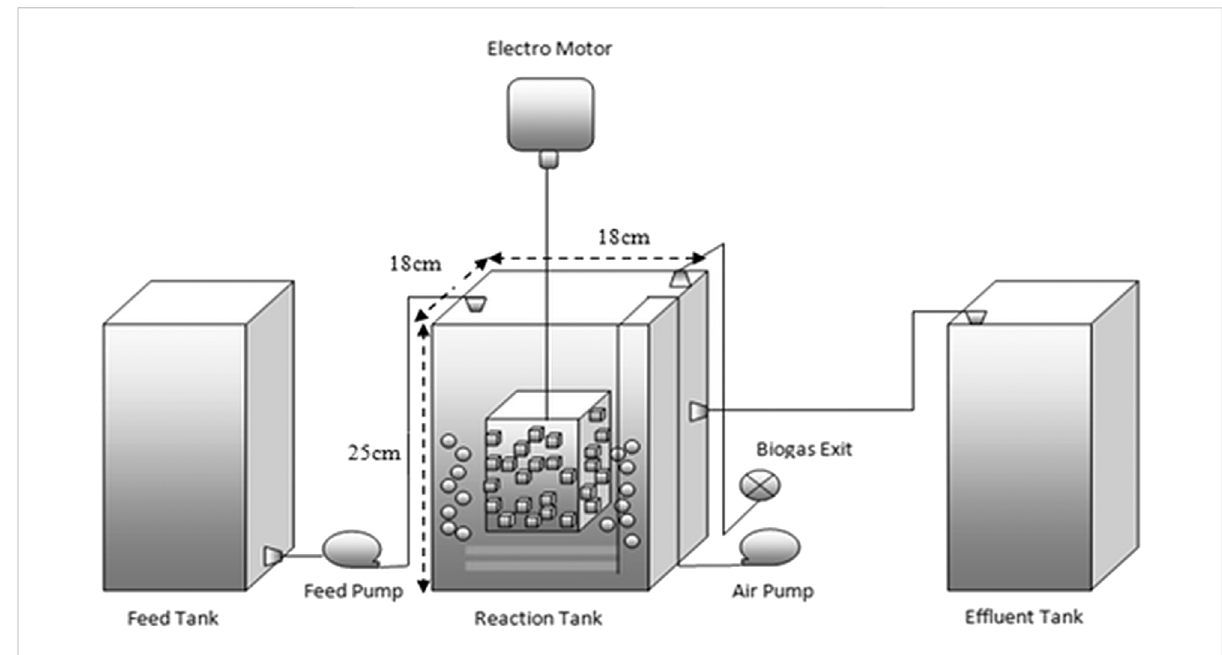
FIGURE 1 Schematic of SBR equipped with a rotating biological